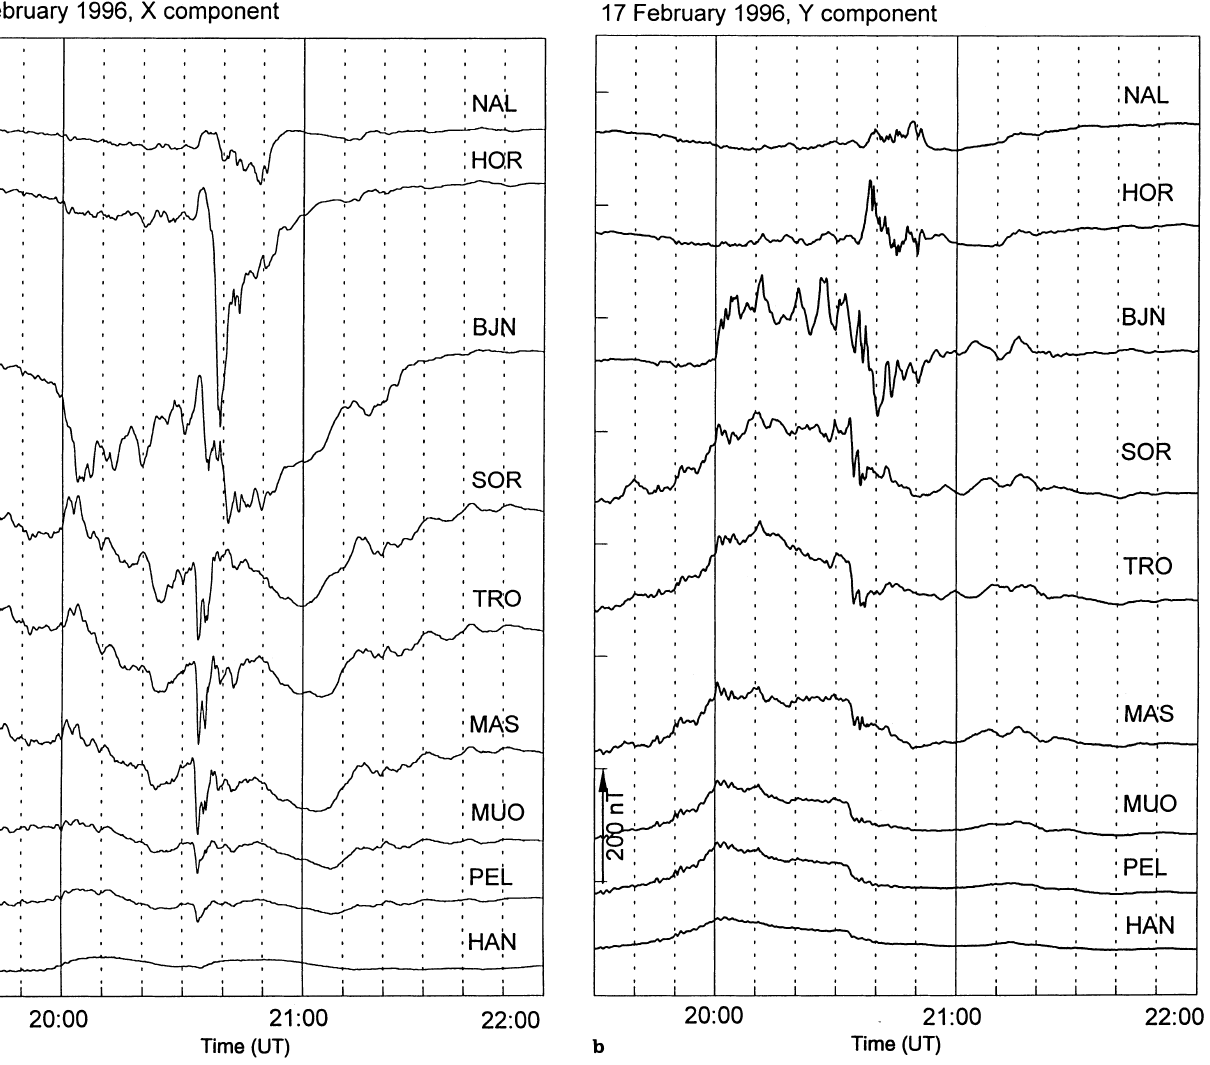
Fig. 3a–c. The behavior of the magnetic field variations from the IMAGE magnetometer stations: a X component; b Y component; c Z